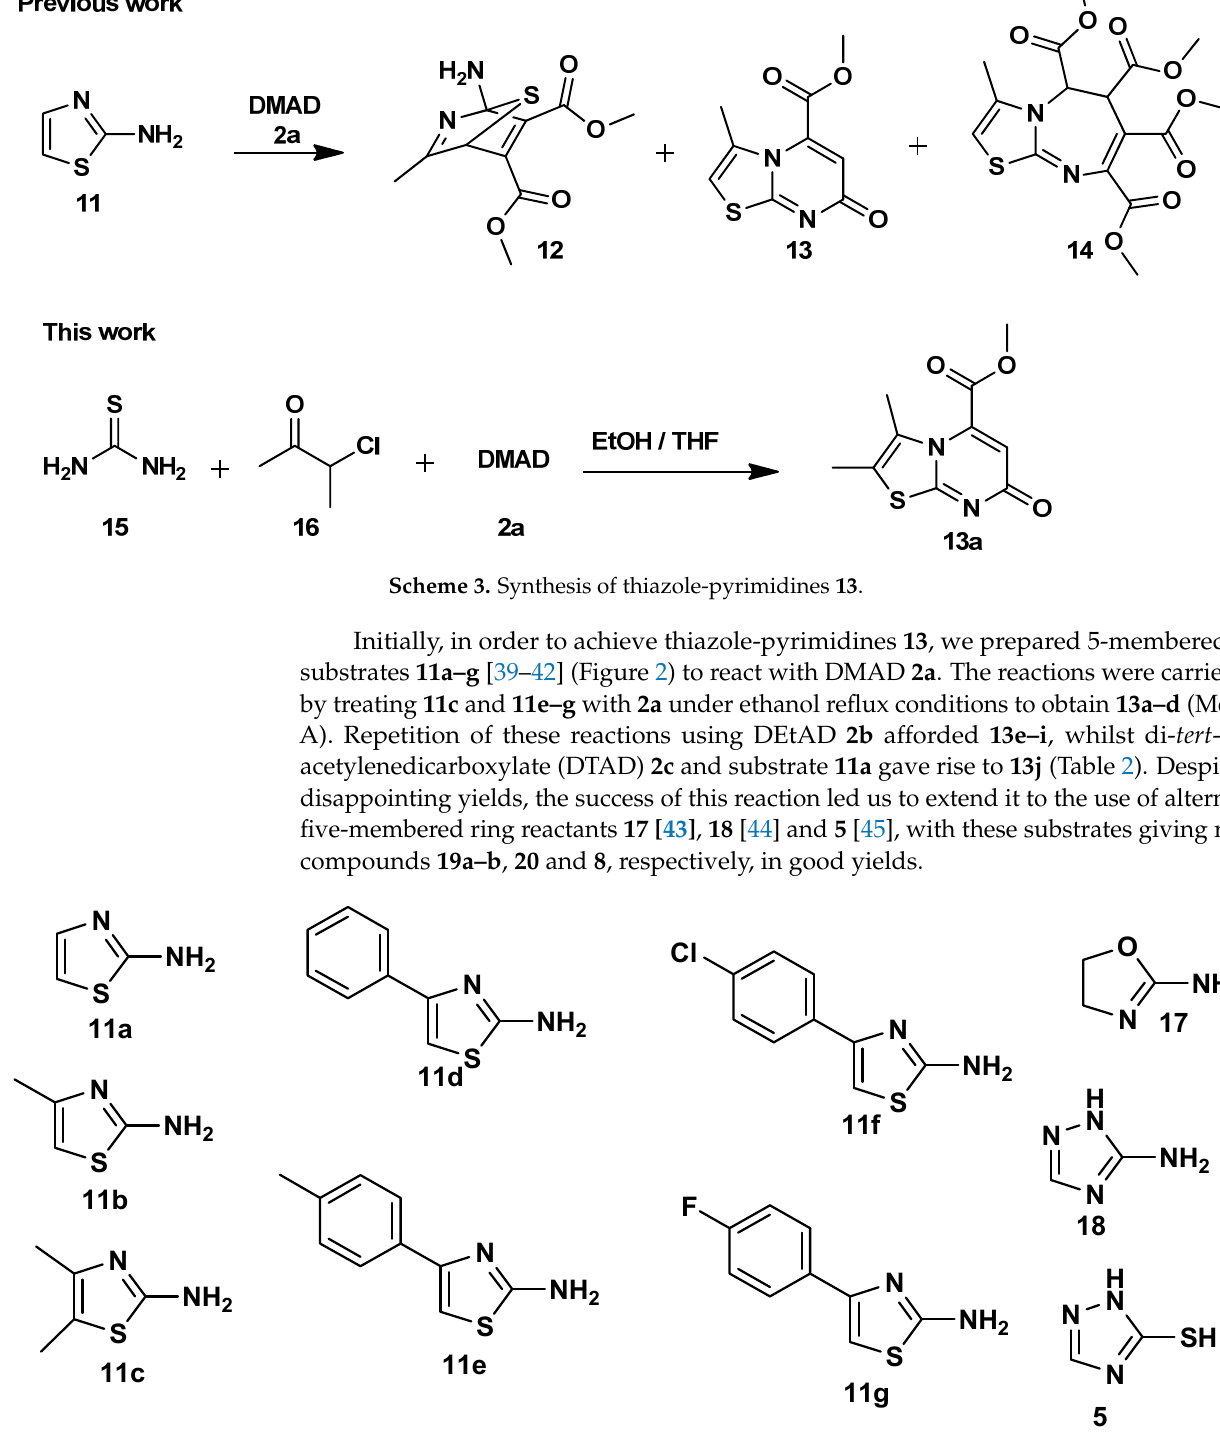
Figure 2. Five membered-ring substrates chosen for the reactions.